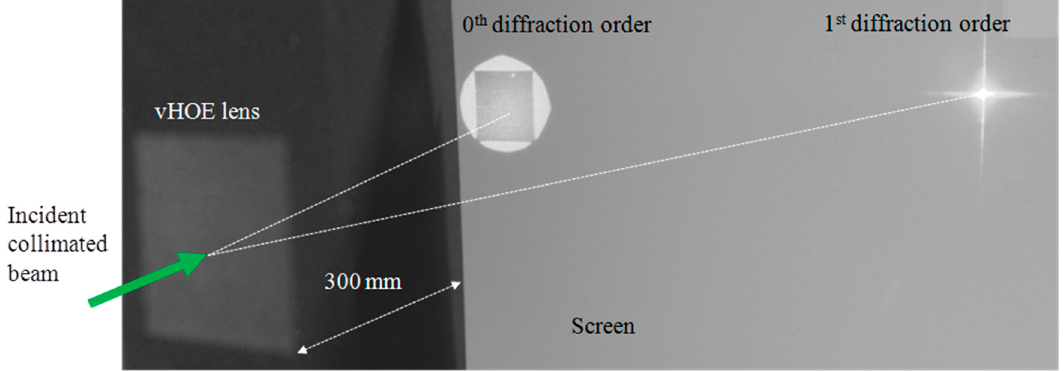
Figure 22. The printed holographic off-axis lens is reconstructed with a plane wave incident under 30° (“On Bragg”) [57]. As the plane wave is larger than the vHOE size a dark square in the 0th diffraction order appears. At the focal distance of 300 mm the 1st diffraction order forms the focal point.